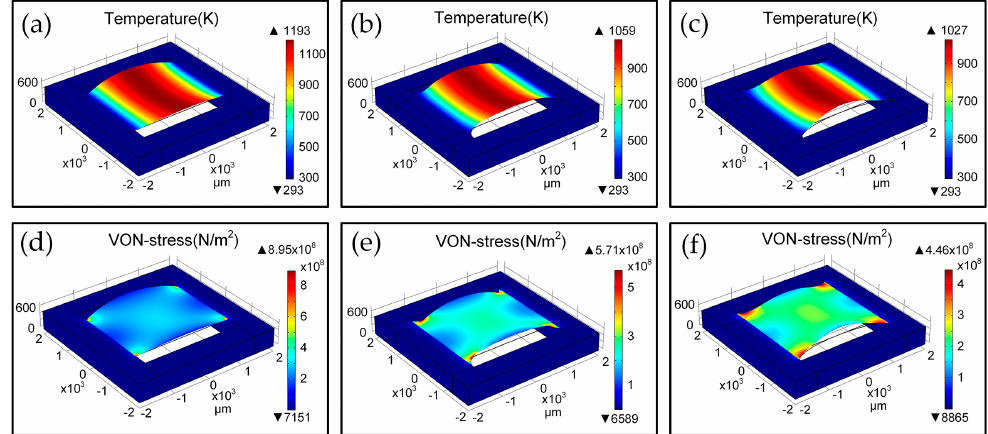
Figure 2. 3D thermal-mechanical simulations of bridge-style hotplate (BSH) emitters using software COMSOL TM . Thermal distribution and deflection for ( a ) BSH-SF, ( b ) BSH-CF, and ( c ) BSH-OF emitters; Stress distribution and deflection for ( d ) BSH-SF, ( e ) BSH-CF, and ( f ) BSH-OF emitters.